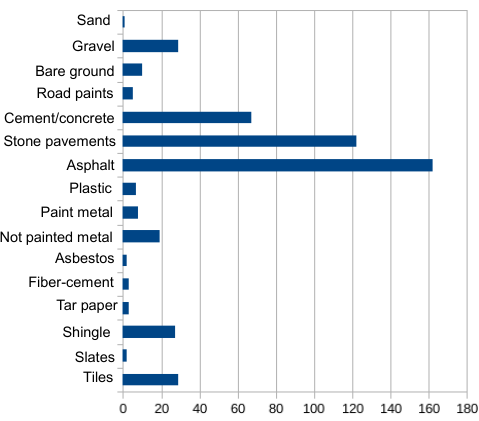
Figure 2: Number of available spectra for the most important material classes